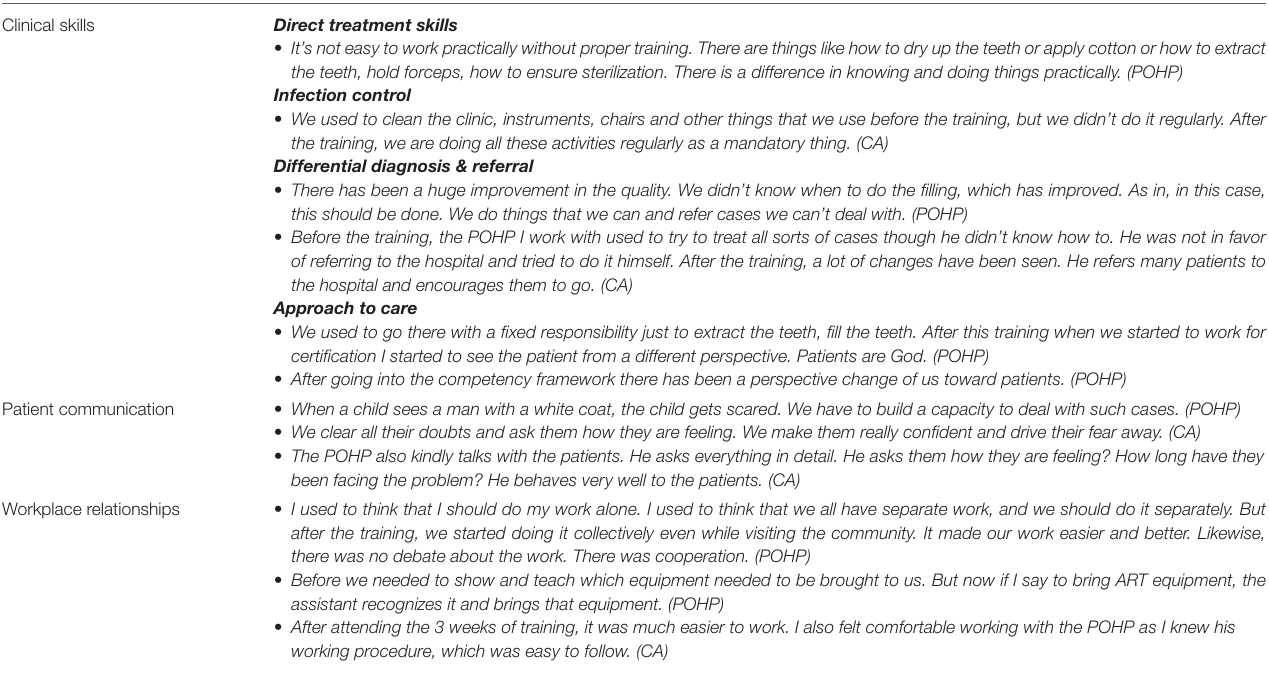
TABLE 3 | Practical improvements. Clinical